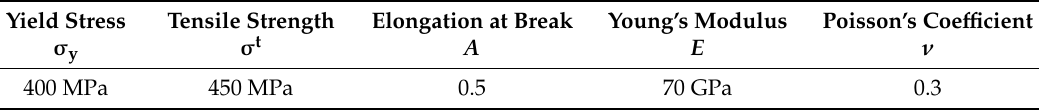
Table 2. Material properties of aluminum rivets.